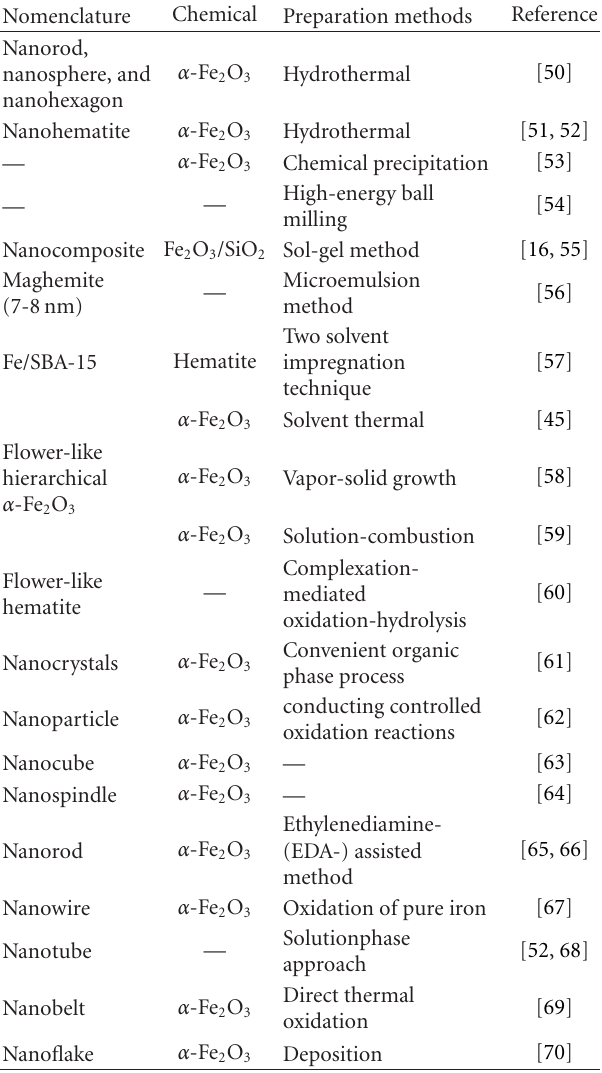
Table 2: Preparation methods of iron